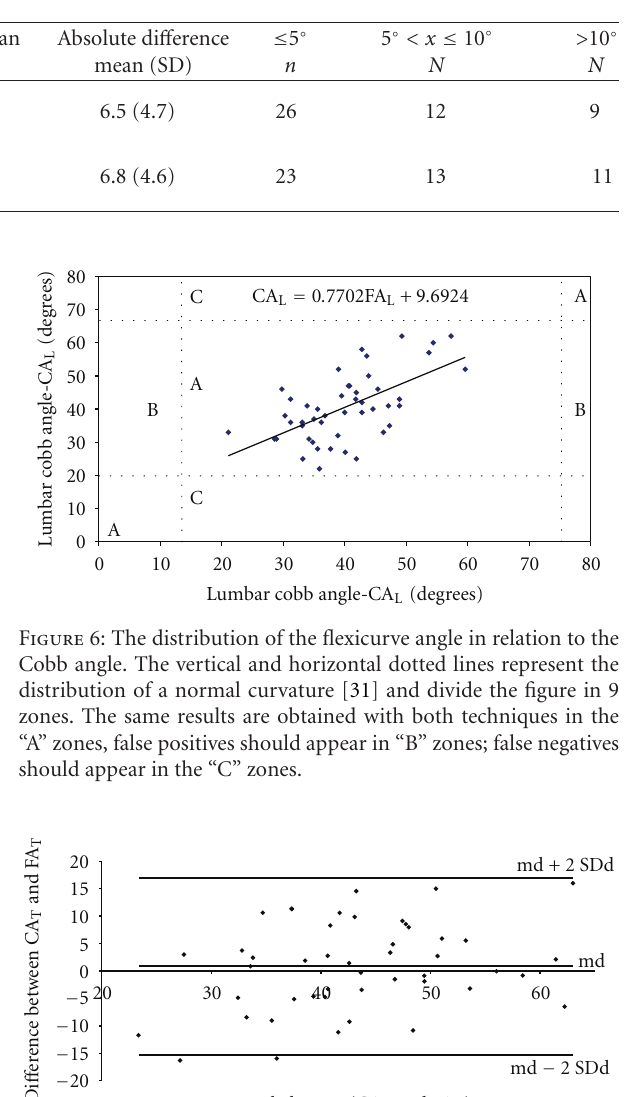
the lumbar curvature. Figures 7 and 8 show that most of the points representing the di ff erence between the CA and FA values are within the limits of agreement (md ± 2 SDd), with random dispersion and average di ff erences approximate to